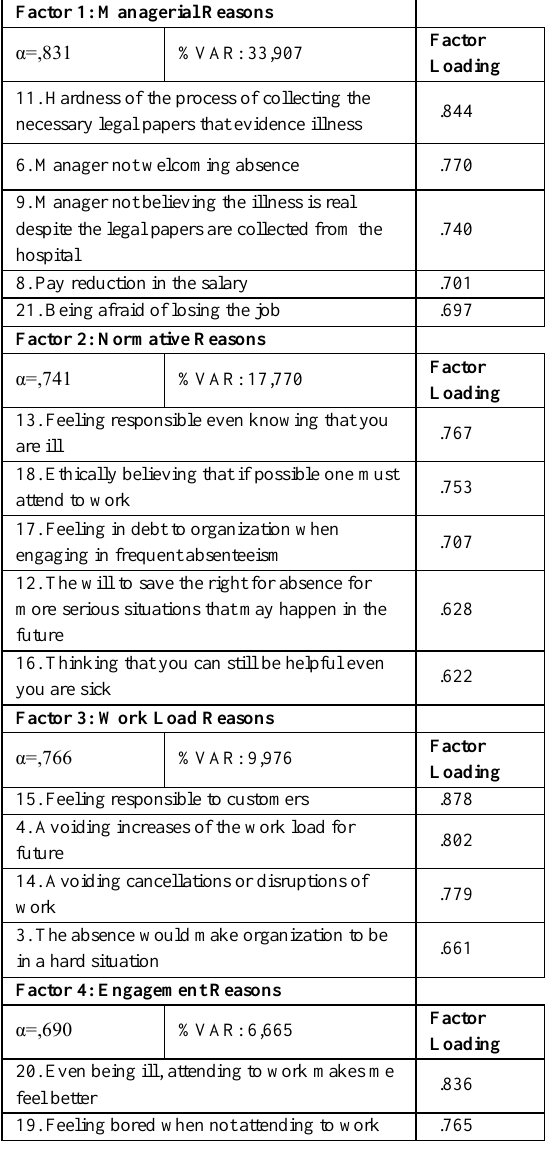
Table 8: Results of Exploratory Factor Analysis